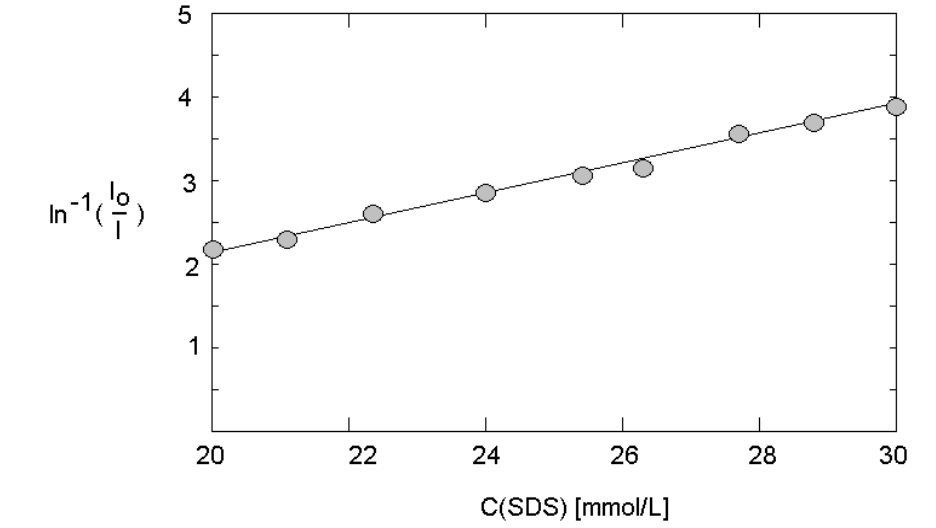
Figure 5. Dependence of fluorescence intensity on the surfactant concentration at micro fluidic conditions (flow rate: 600 µL/min; quencher concentration: 10 -4 mol/L; dye concentration: 10 -4